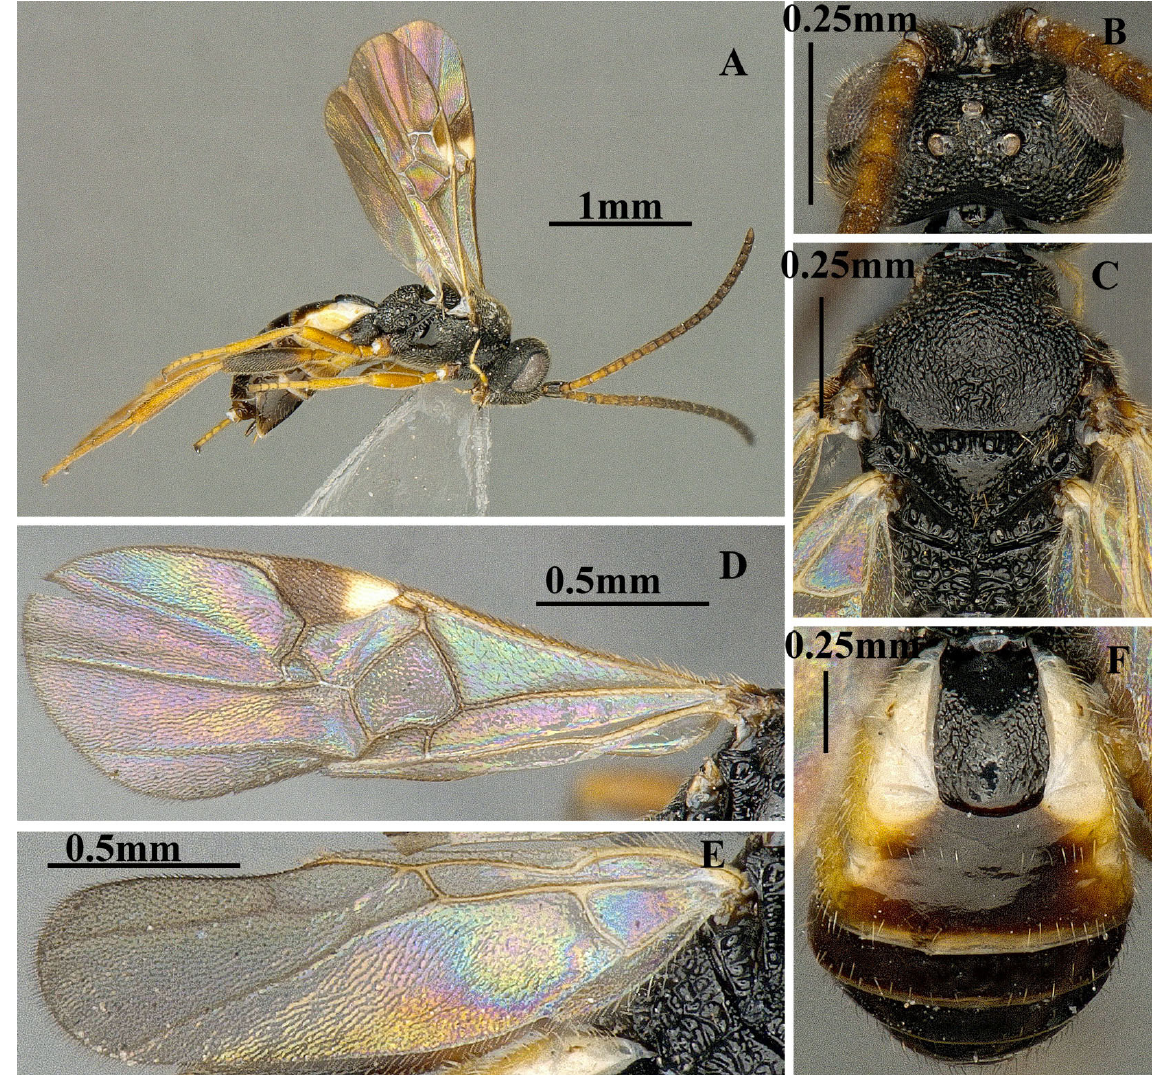
Fig. 11. Microplitis spectabilis (Haliday, 1834), ♀, TMUC-HBMMP0061. A . Habitus, lateral view. B . Head, dorsal view. C . Mesosoma, dorsal view. D . Fore wing. E . Hind wing. F . Metasoma, dorsal view